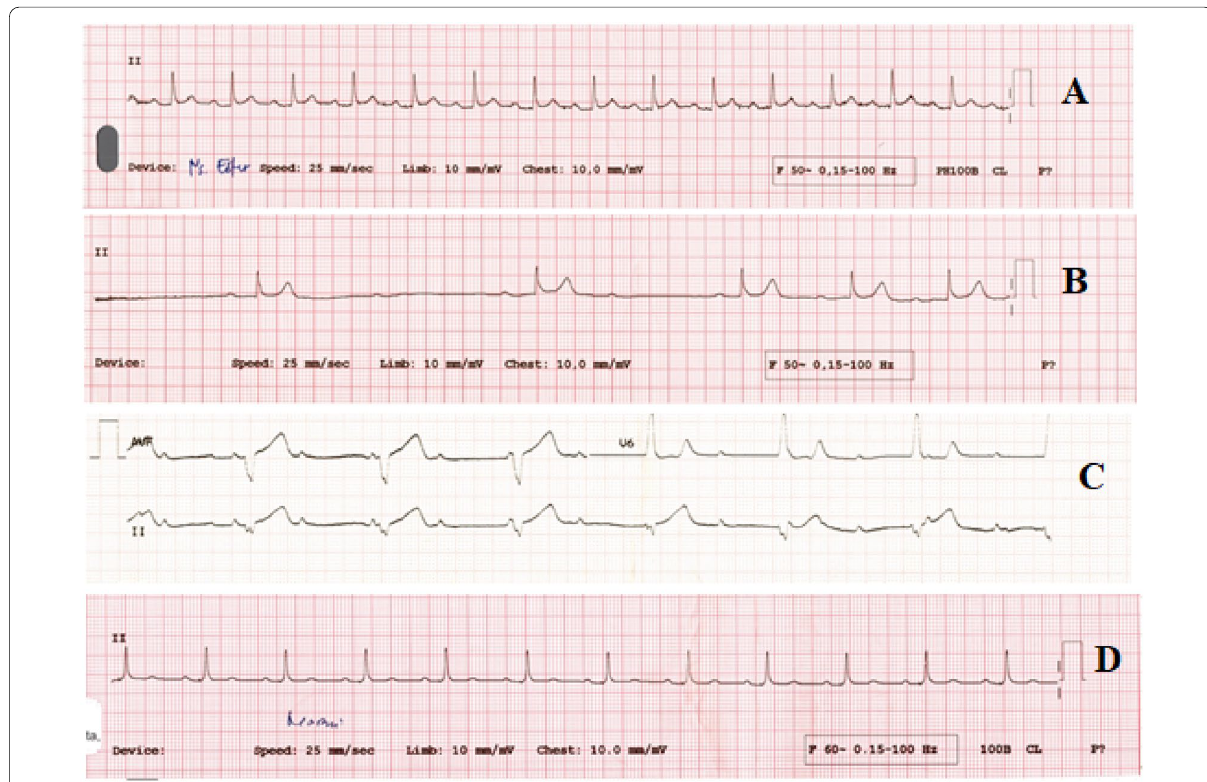
Fig. 1 A . ECG at admission showed first degree AV block with narrow QRS duration, B . At second day hospitalization showed a 2:1 alternating with Mobitz 1 AV Block, C . On the 9th day of hospitalization, complete AV block with idioventricular escape rhythm occurred suggesting infra-His block, D . His bundle pacemaker implantation resulted in narrow QRS duration and pseudo-delta wave preceded with pacing spike resembling non-selective His bundle